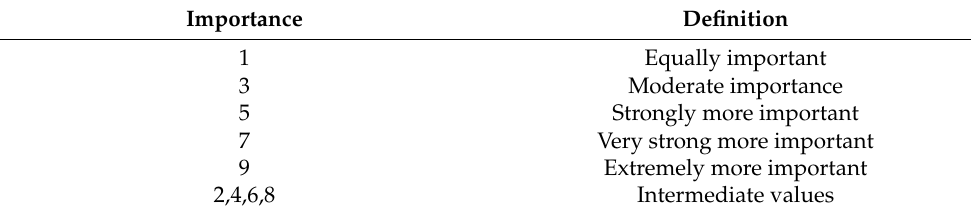
Table 4. Saaty importance scale.